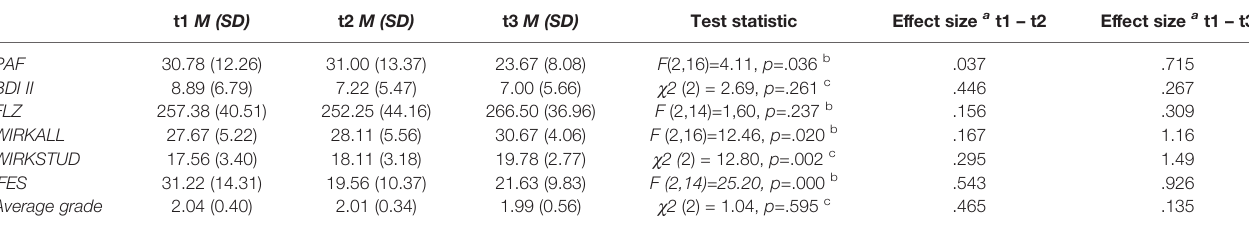
TABLE 2 | Changes in outcome variables over time: Means, standard deviations, test statistics and effect sizes at baseline (t1), post-treatment (t2), 3 months follow-up (t3) ( n = 9). t1 M (SD) t2 M (SD) t3 M